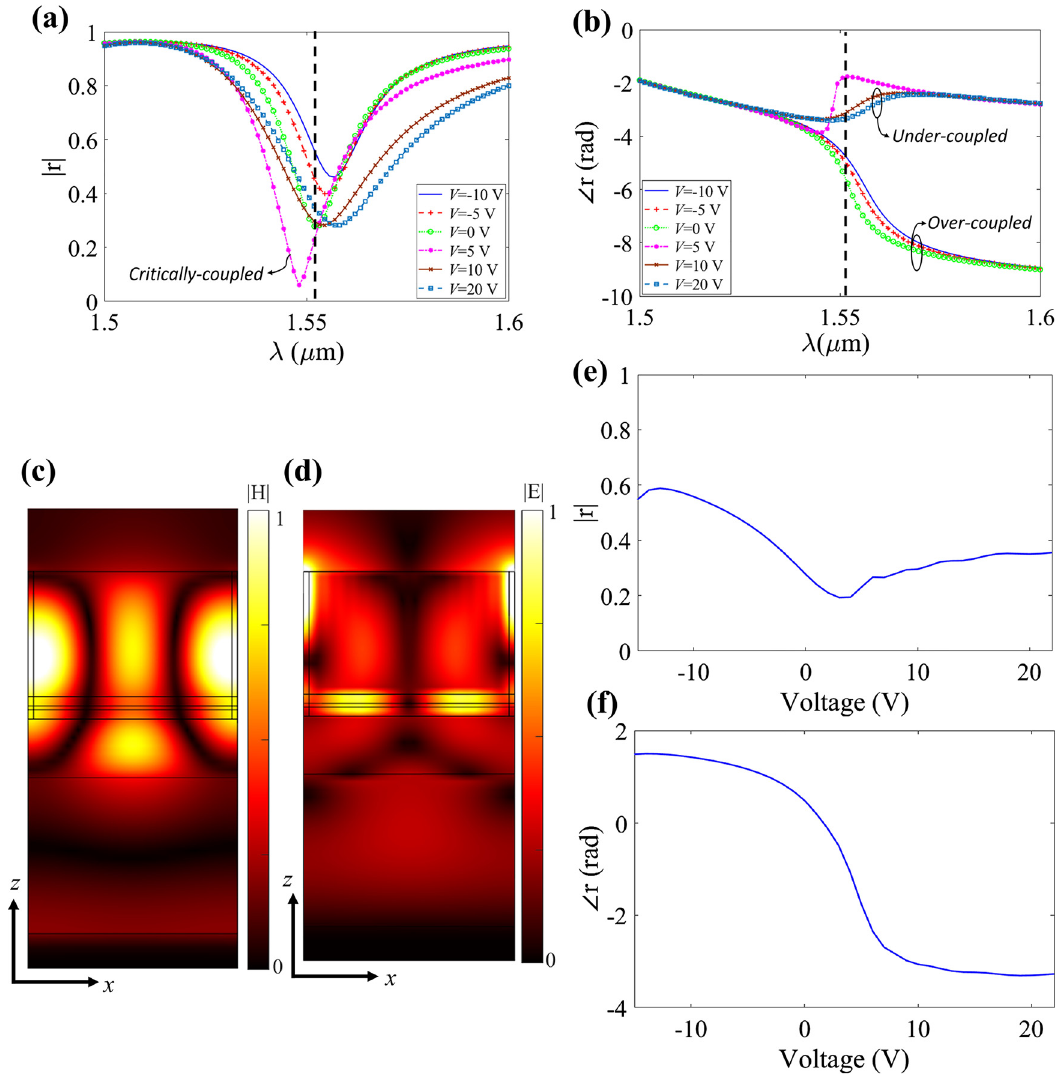
Figure 4: (a) The amplitude and (b) phase of re fl ection calculated as functions of wavelength at different applied bias voltages. The vertical dashedlinemarkstheoperatingwavelengthof λ 0 (cid:2) 1 . 552 μ myieldingmaximaldynamicphasespanwithminimalvariationsintheamplitude. Thecalculatednear fi elddistributionof (c) magneticand (d) electric fi eldwithintheunitcellinthex-zplane.The (e) amplitudeand (g) phaseof re fl ection calculated as functions of applied bias voltage at the operating wavelength of λ 0 (cid:2) 1 . 552 μ